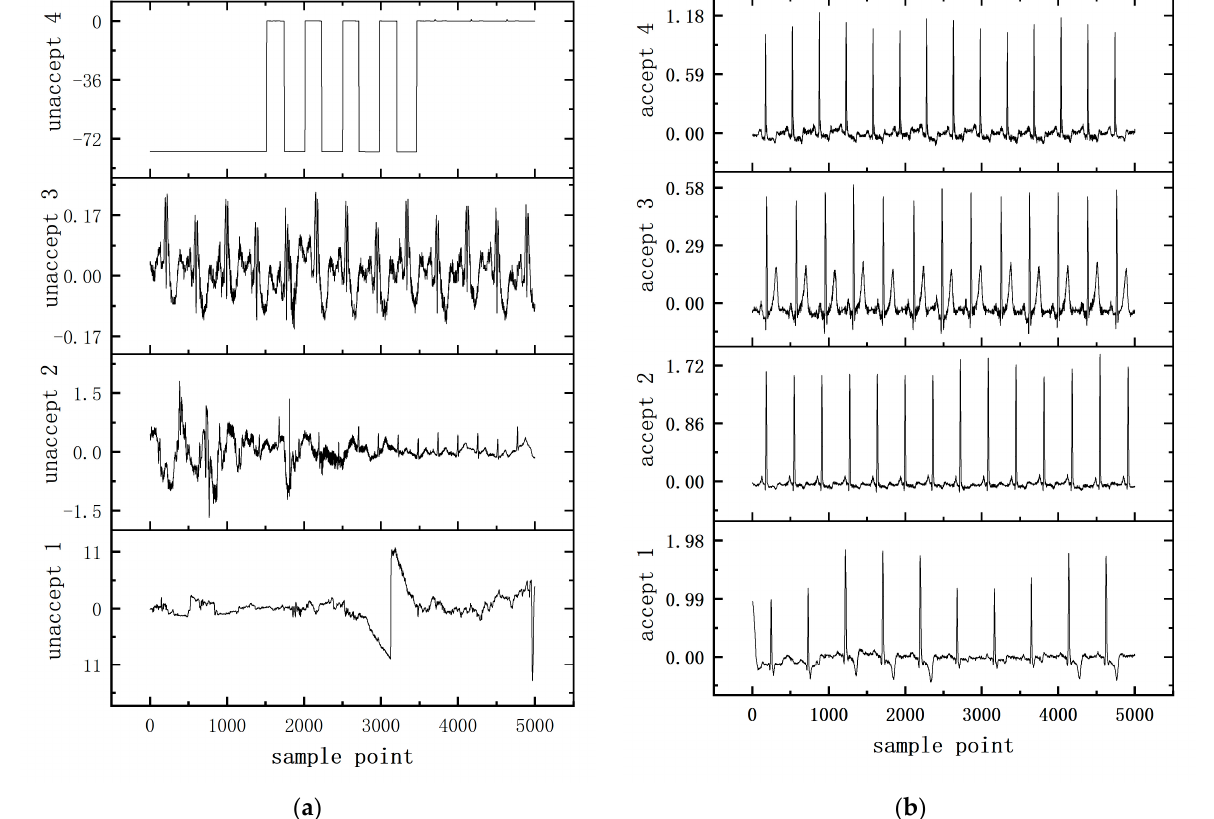
Figure 2. ( a ) Unacceptable sample diagram; ( b ) acceptable sample diagram.